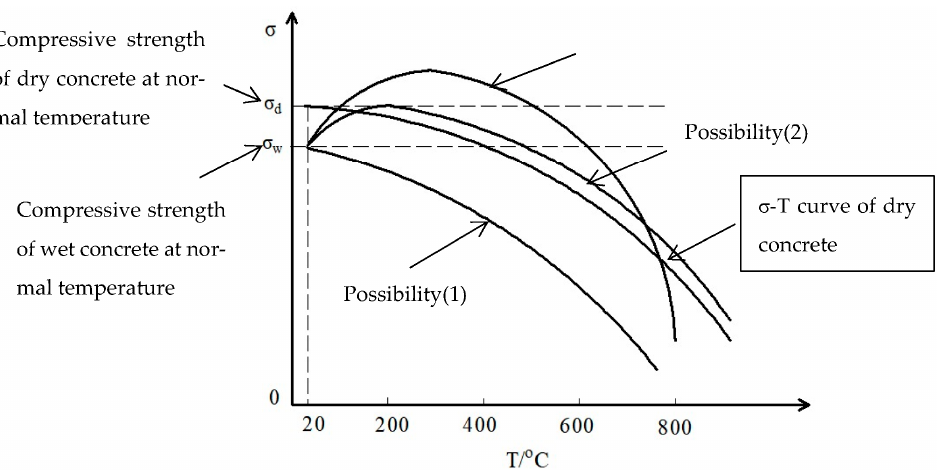
Figure 1. The schematic diagram of the possible relationship between compressive strength and temperature.